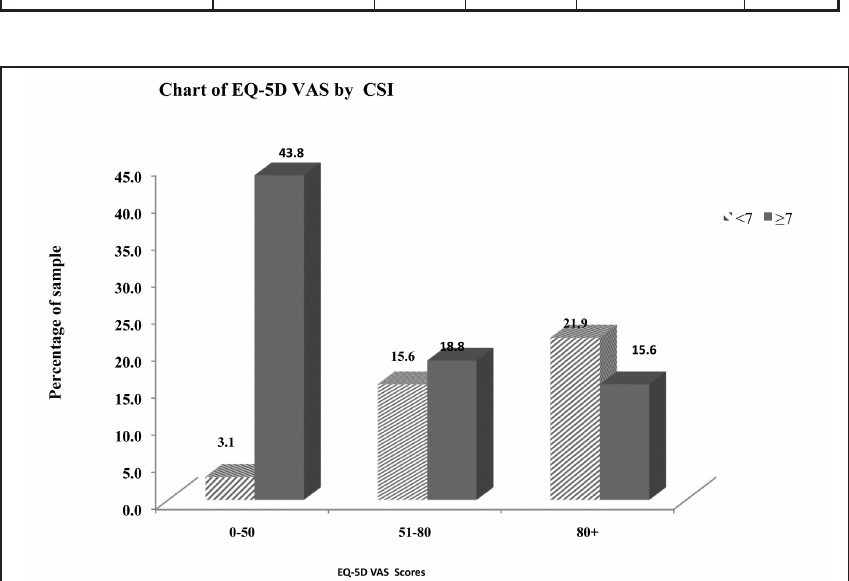
Figure 3: Frequency distribution between CSI and EQ-5D VAS scores